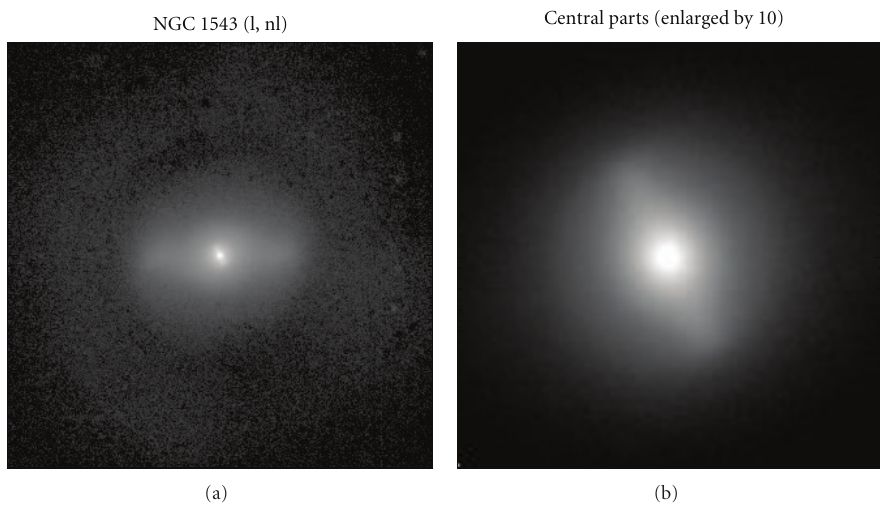
Figure 3: Two subfigures from Figure 15 in Laurikainen et al. [25] are shown. In (a) the whole galaxy is shown using the full magnitude range of the image. In this image the outer lens and the inner lens surrounding the main bar are clearly visible. In (b) only the central regions of the galaxy is shown (enlarged by a factor of 10), demonstrating the morphology of the nuclear bar and the nuclear lens extending to the radius of the nuclear bar.